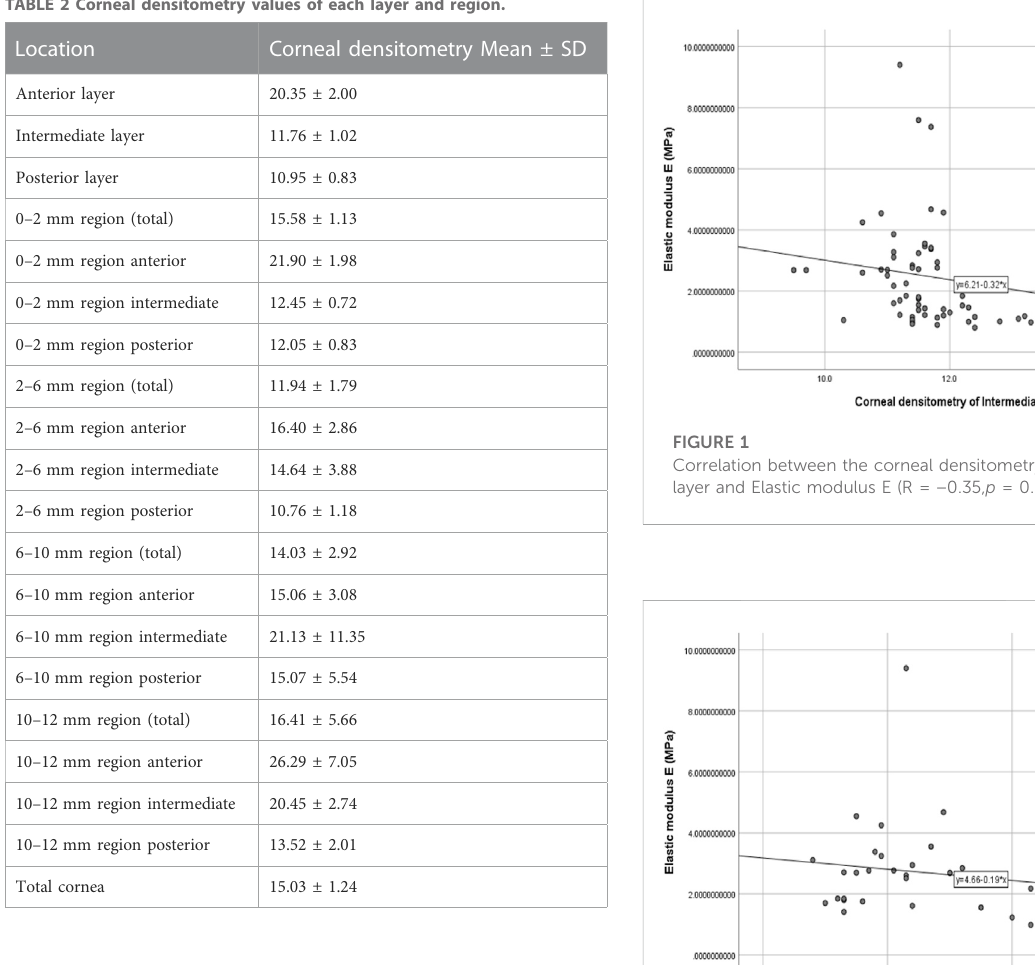
TABLE 3 Correlation analysis between elastic modulus E and corneal densitometry values. Corneal densitometry